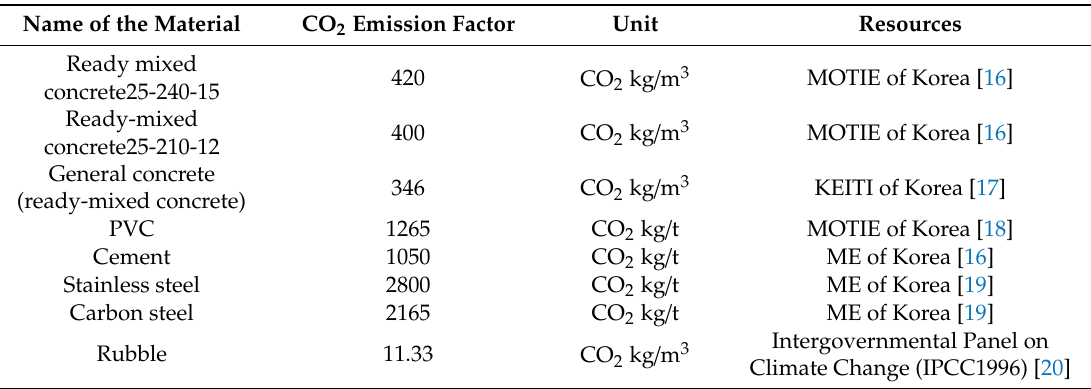
Table 1. CO 2 emission factors of materials.